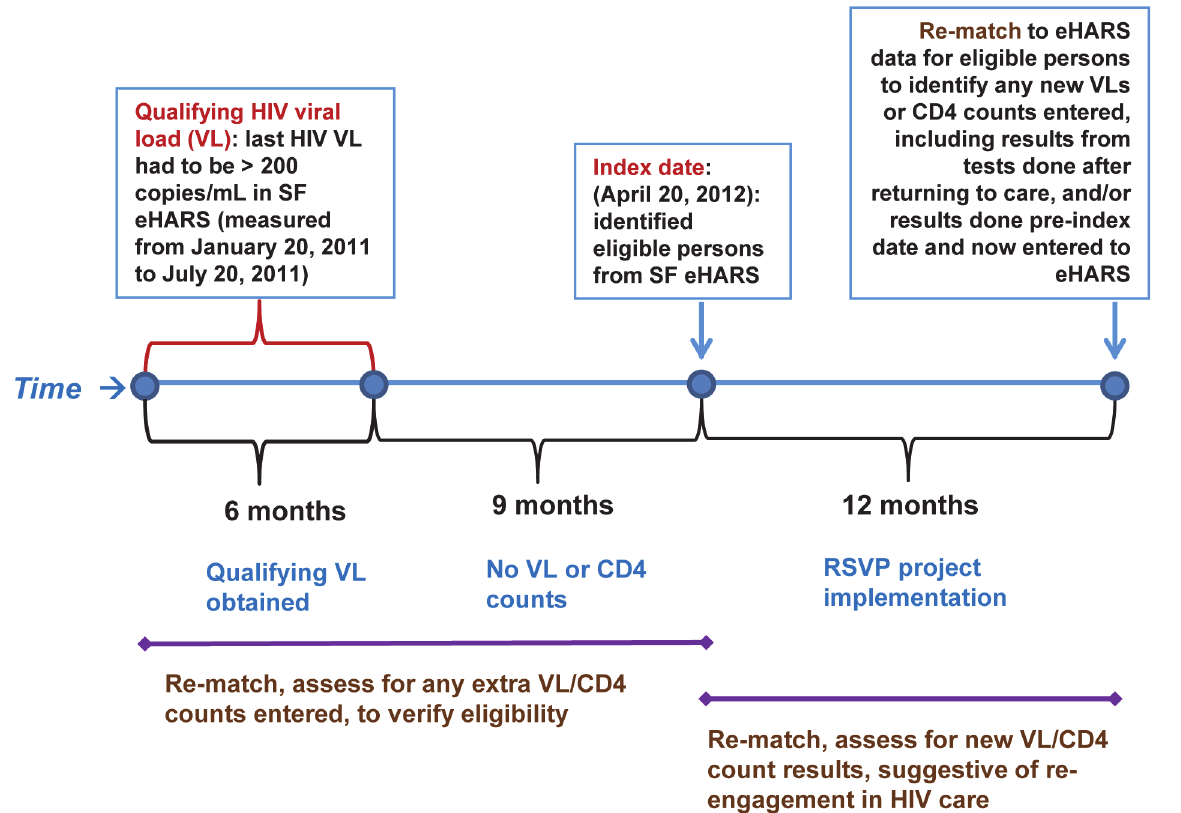
Fig 1. Re-engaging Surveillance-Identified Viremic Persons (RSVP) Project in San Francisco, 2012 – 2013: Design and Timeline.